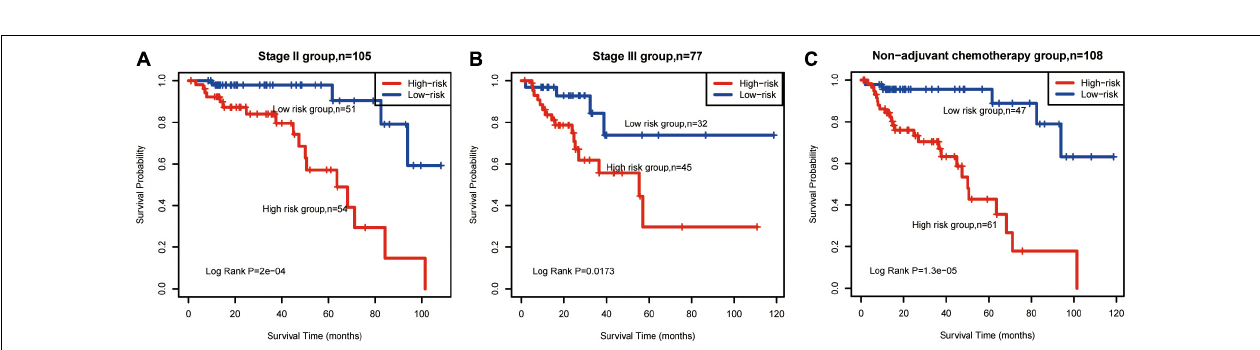
FIGURE 2 | Prognosis of patients with stage II/III CRC was predicted using the methylated signature. (A,B) Based on Kaplan–Meier survival curves, patients with stage II/III CRC were classified into high- and low-risk groups using methylation sites as signature in the training and test groups. P -values were calculated via log-rank test. (C,D) Comparison of the sensitivity and specificity for the prediction of overall survival (OS) based on the CG Score and other clinical parameters. Receiver operating characteristics (ROC) curves for the (C) training and (D) test groups. CRC, colorectal cancer; MSI, microsatellite instability; TMB, tumor mutational burden; AUC, area under the curve; CG score, CG site-based risk score.